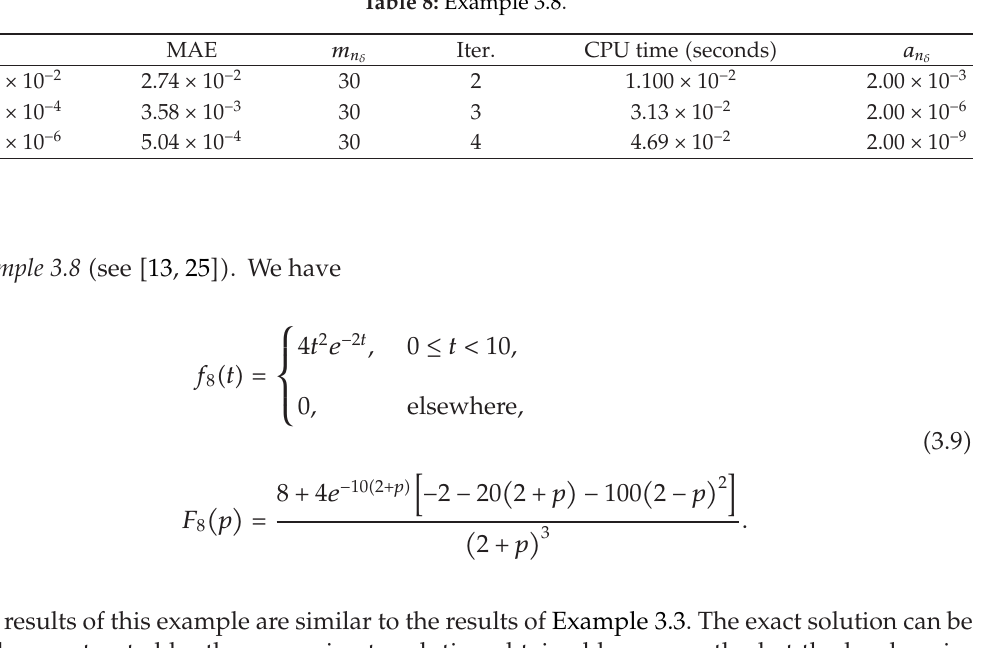
Table 8: Example